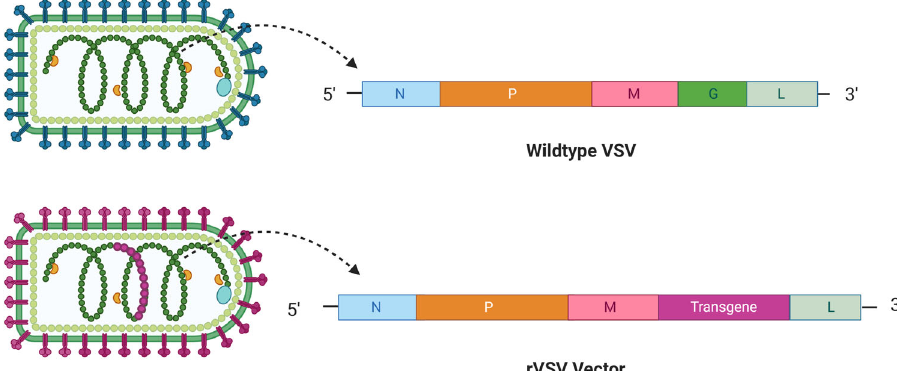
Fig. 3 Schematic representation of the wildtype VSV and an rVSV vector. The wild type virus is a negative-sense RNA virus that encodes the nucleoprotein (N), phosphoprotein (P), matrix (M), glycoprotein (G), and RNA-dependent RNA polymerase (L) proteins. When the viral vector is used in vaccinations, the G gene is replaced with the transgene of